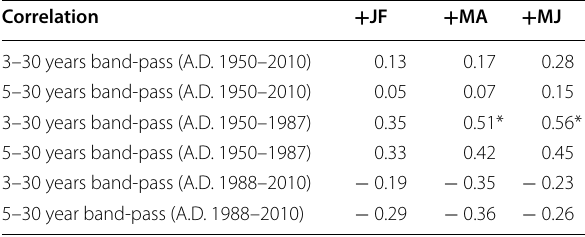
JF (magenta line), MA (red + +